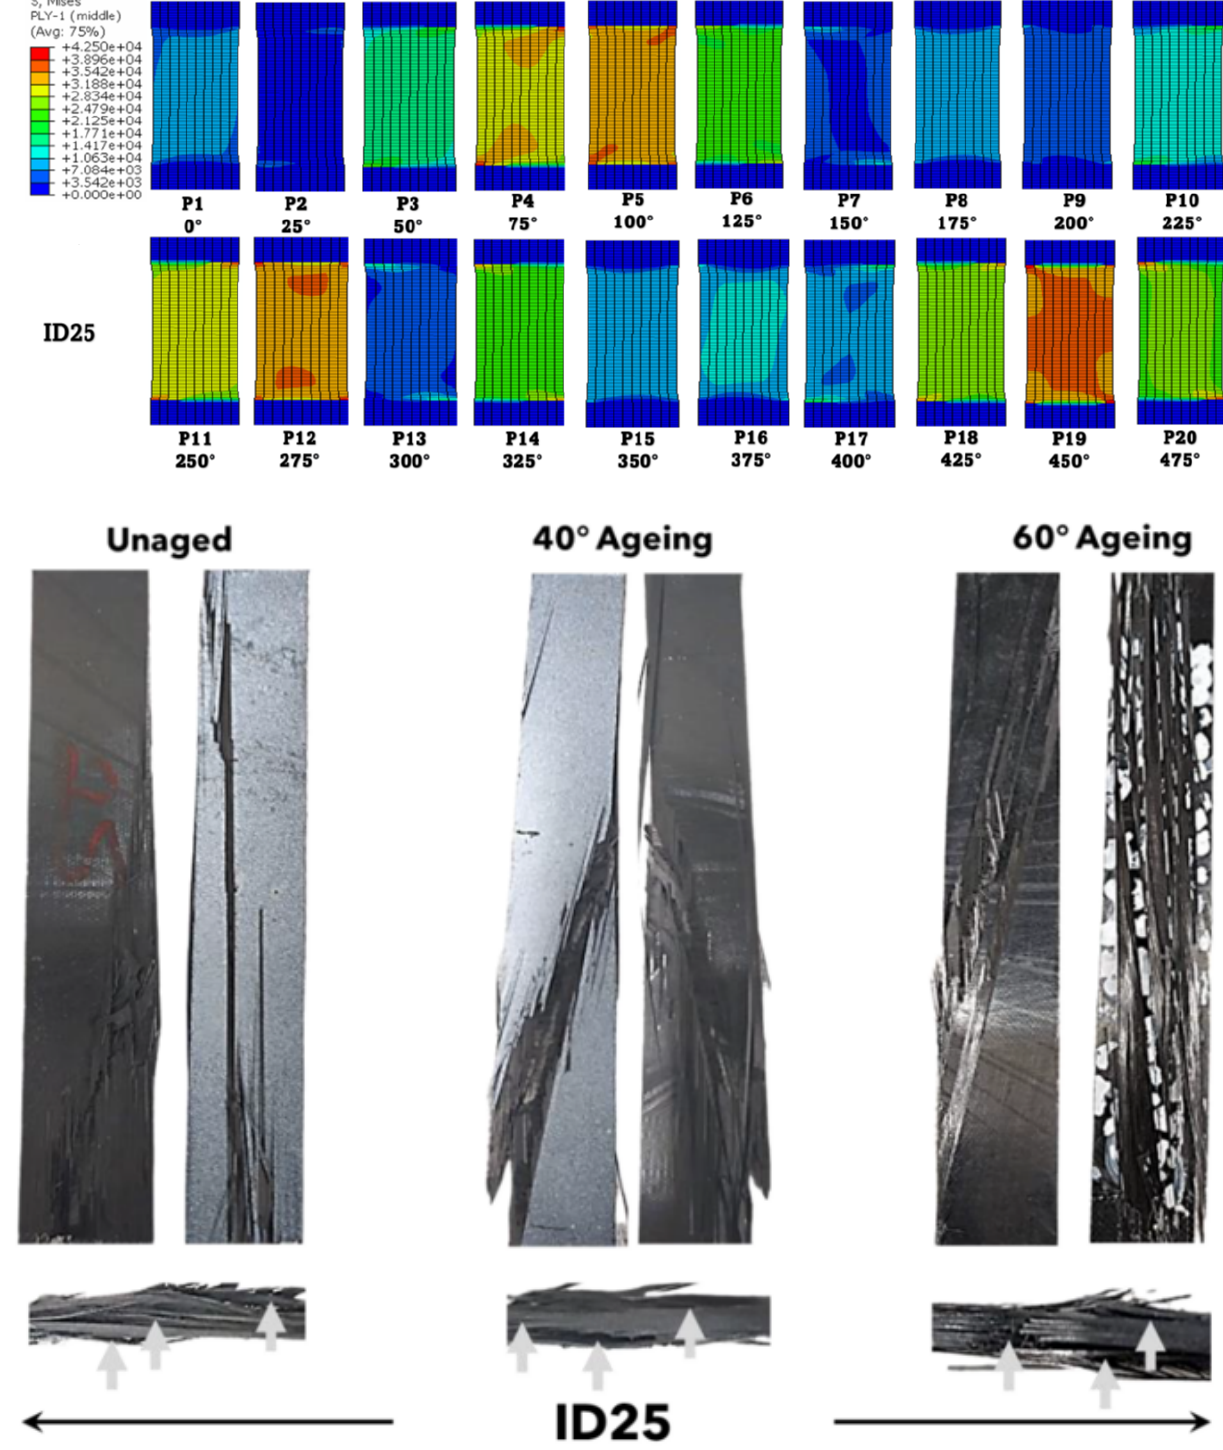
Figure 10. Stress (von Mises) distributions in individual dry plies predicted using the Hashin failure model, for ID25 composites ( top ), front and back face fractures from representative dry, 40 ◦ C, and 60 ◦ C aged samples ( middle ), and side view fractures from representative dry, 40 ◦ C, and 60 ◦ C aged samples ( bottom ), with arrows indicating the primary areas of fracture